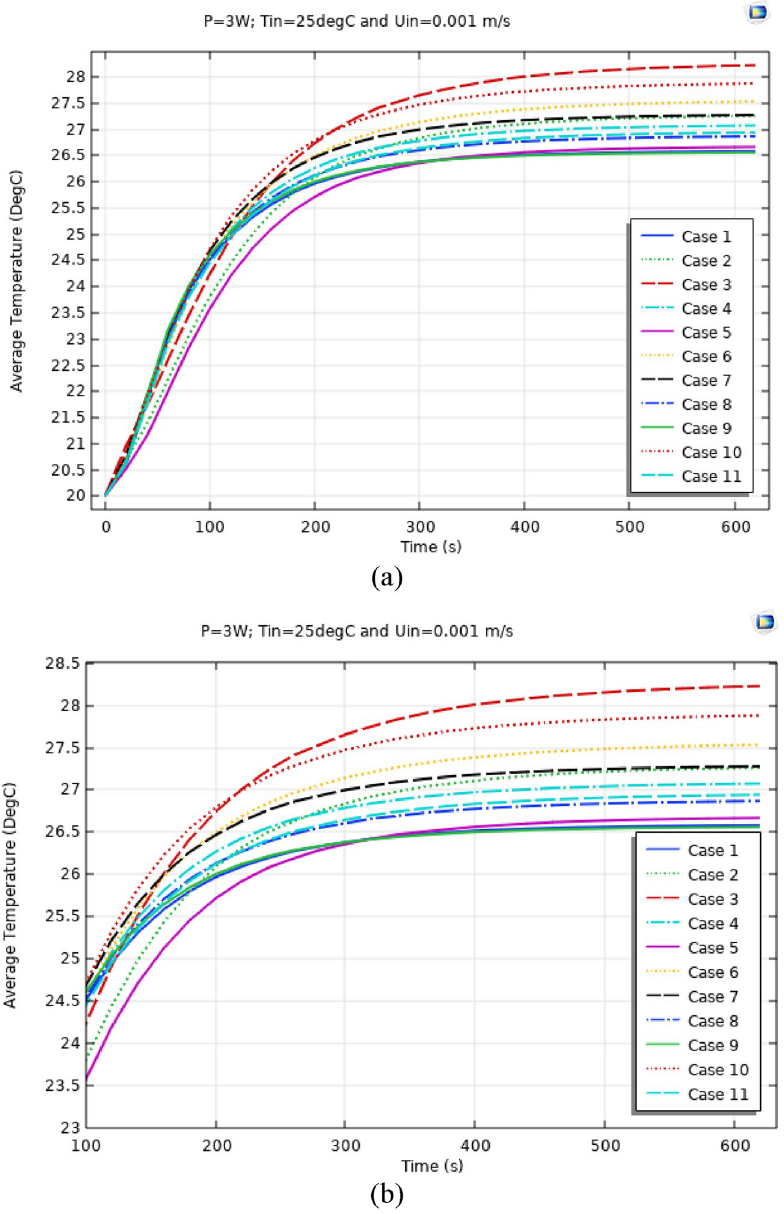
Figure 9. Average Temp. when P = 3 W for different 11 cases ( a ) complete view, ( b ) zoomed